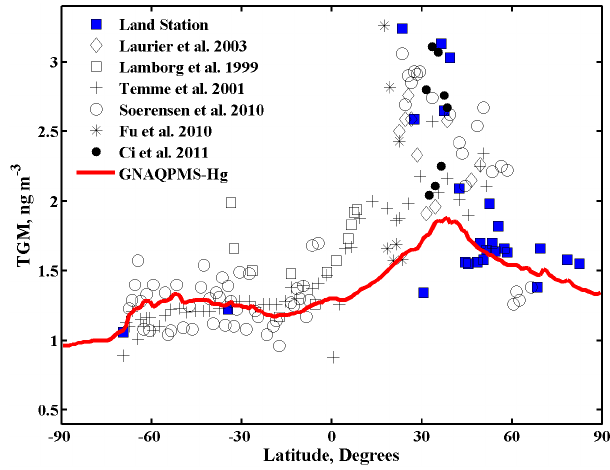
Figure 4. Variation of surface TGM concentrations (ngm − 3 ) with latitude. Zonally averaged, annual mean model results (line) are compared to observations